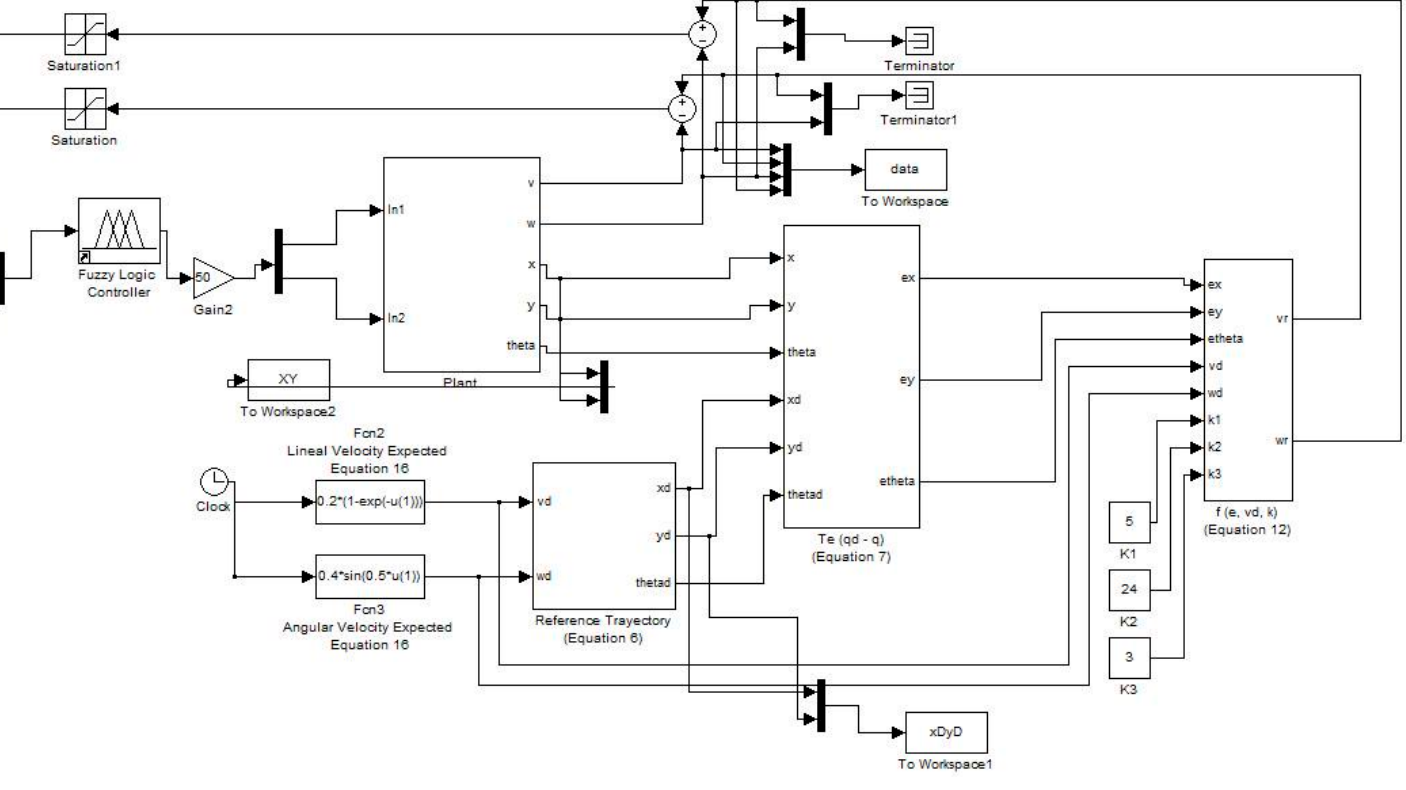
Figure 10. Fuzzy controller of the autonomous mobile robot.